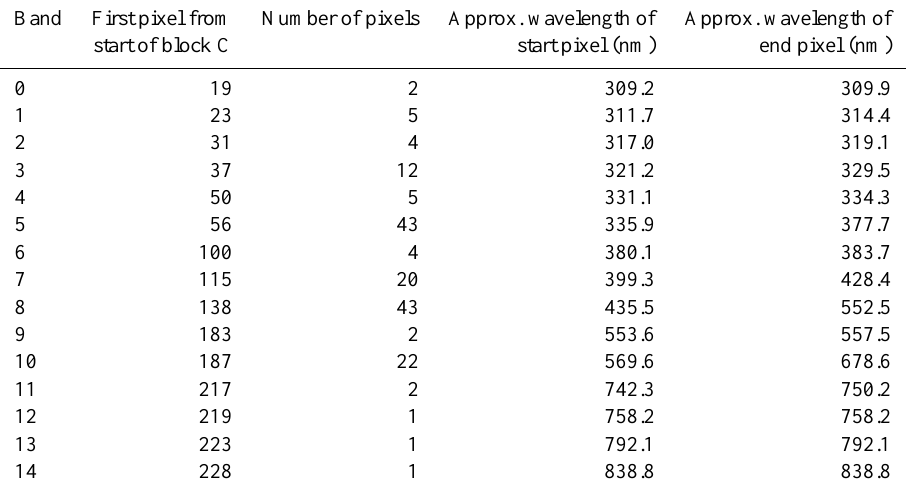
Table 4. Default GOME-2 Metop-A PMD band definitions (v1.0) valid from date of launch to 11 March 2008 in orbit 7226.